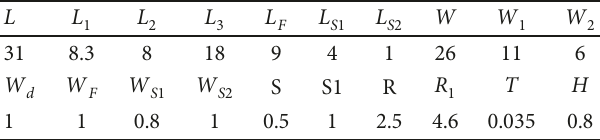
Figure 1: Structure of the proposed antenna. Table 1: Dimensions of the proposed antenna in